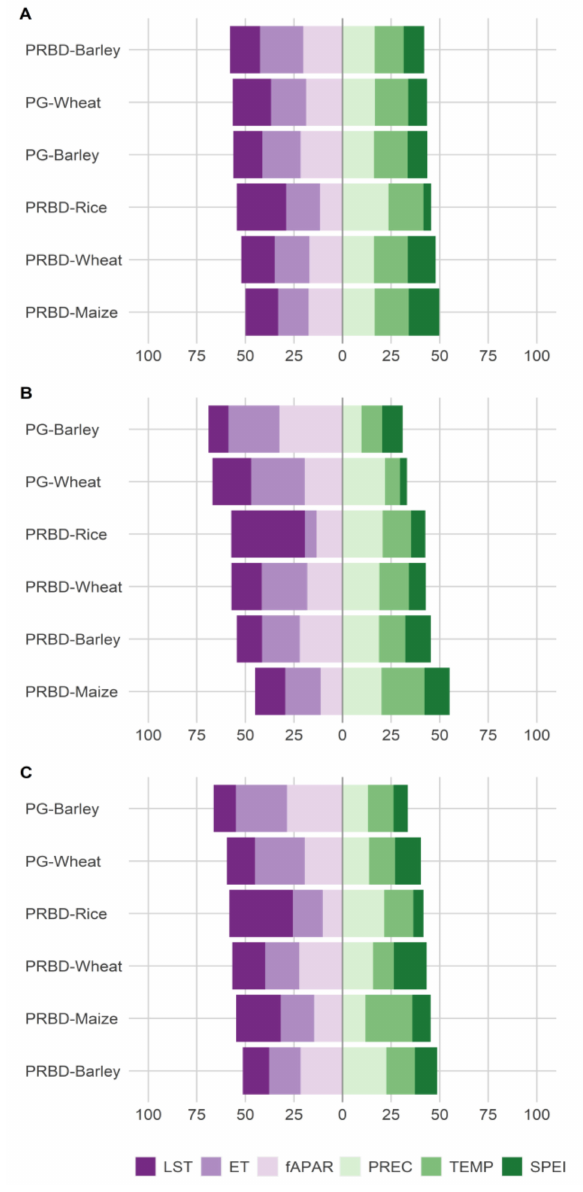
Figure 5. Relative weight (%) of satellite-based indicators (purple-left) compared to meteorological indicators (green-right), within all selected features in lasso models at the province ( A ), agricultural district ( B ) and municipality level ( C ), for all the region-crop